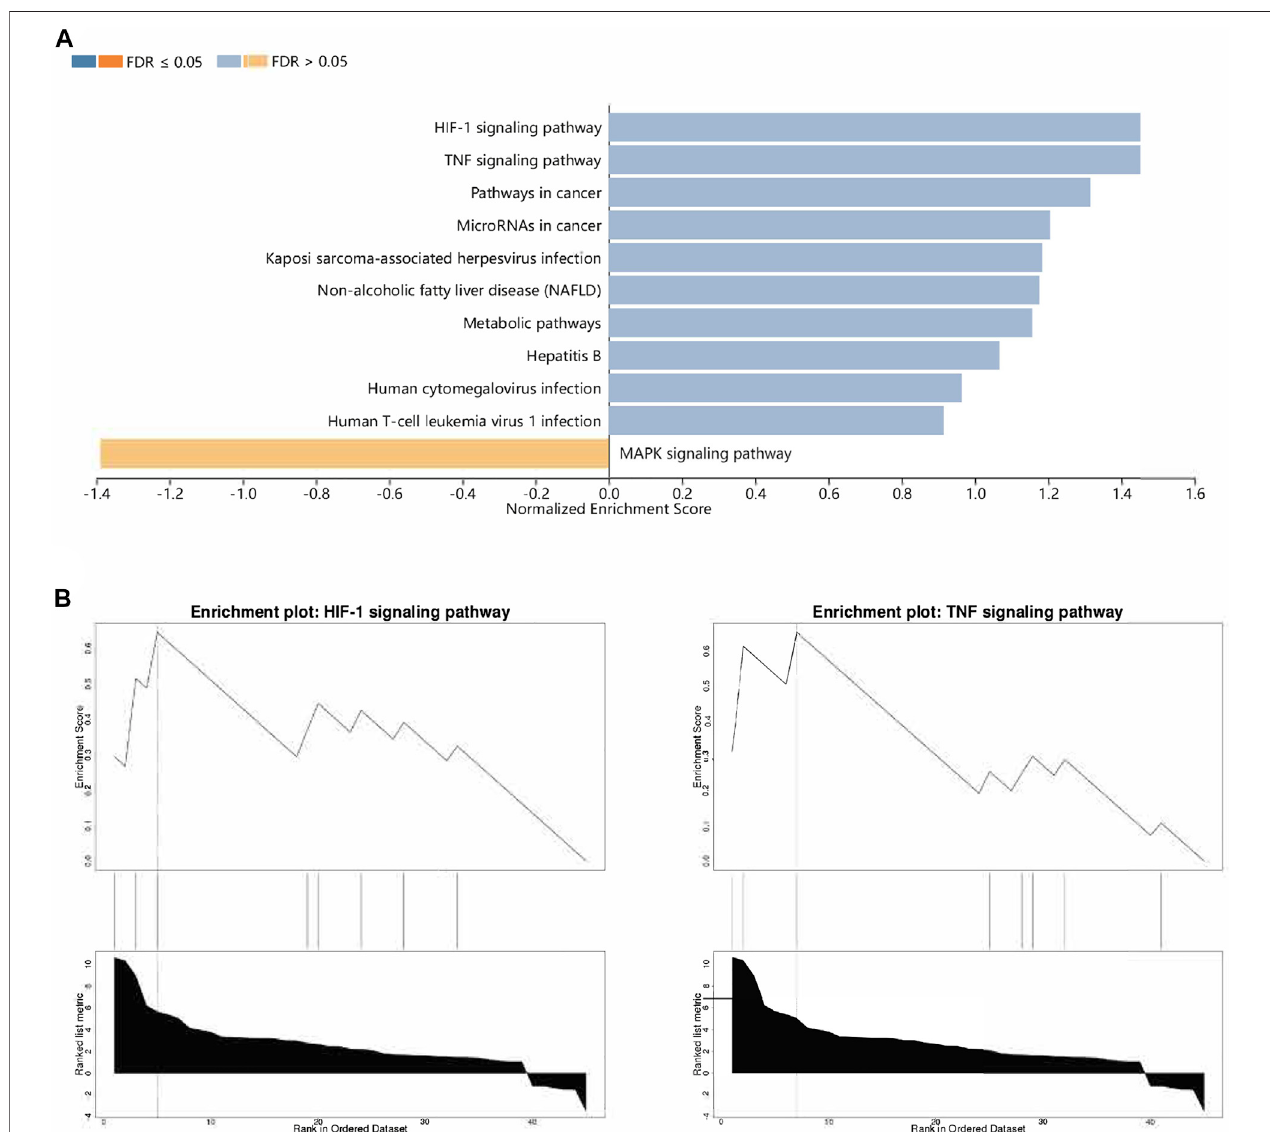
FIGURE 4 | Functional analyses of ferroptosis DEGs using WebGestalt. (A) Enriched pathways identi fi ed by the enrichment gene dataset analyses. (B) Top two enriched pathways analyzed using WebGestalt. Abbreviations: DEGs, differentially expressed genes.